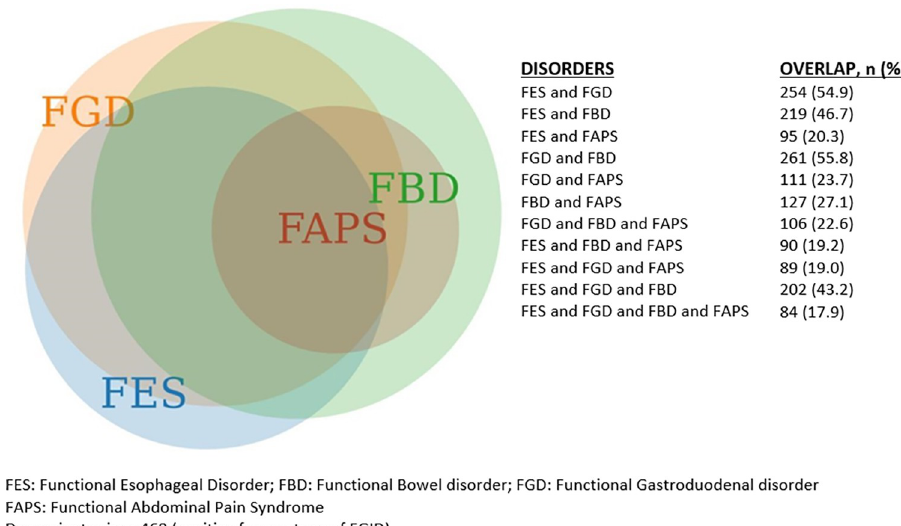
Fig 2. Overlap between Functional Gastrointestinal